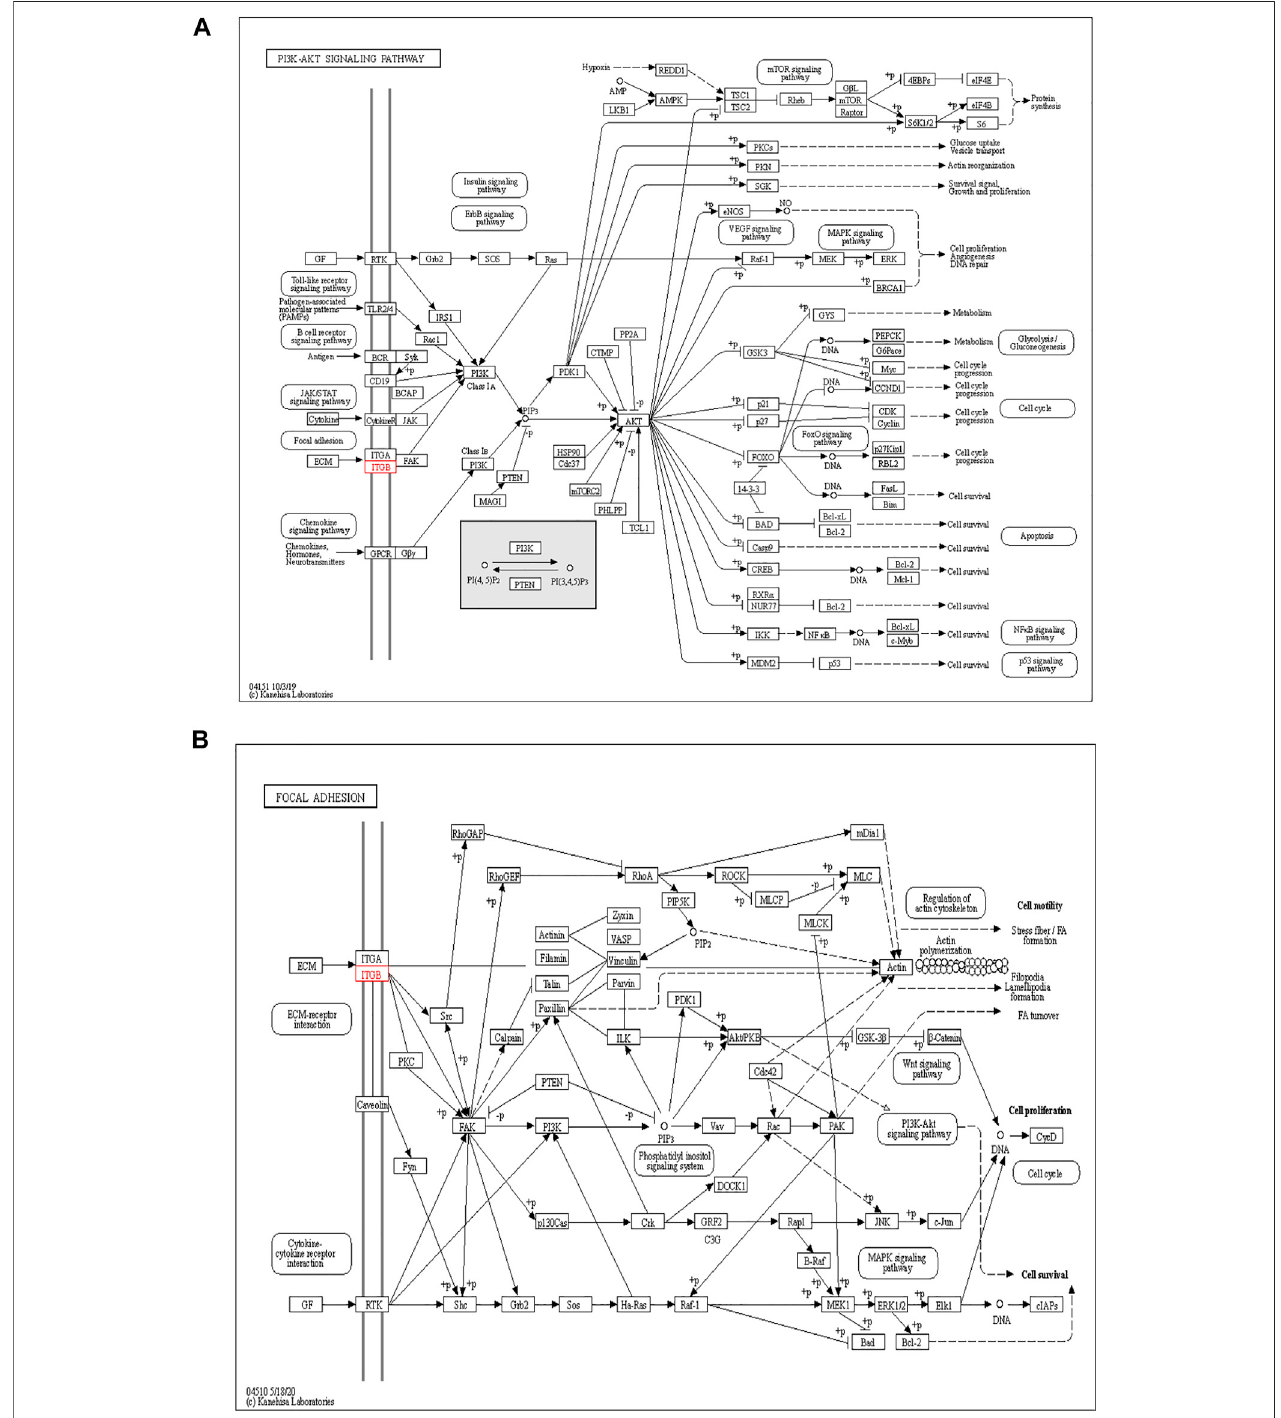
FIGURE 11 | PI3K-Akt signaling pathway (A) and focal adhesion procedure (B) regulated by ITGBs.